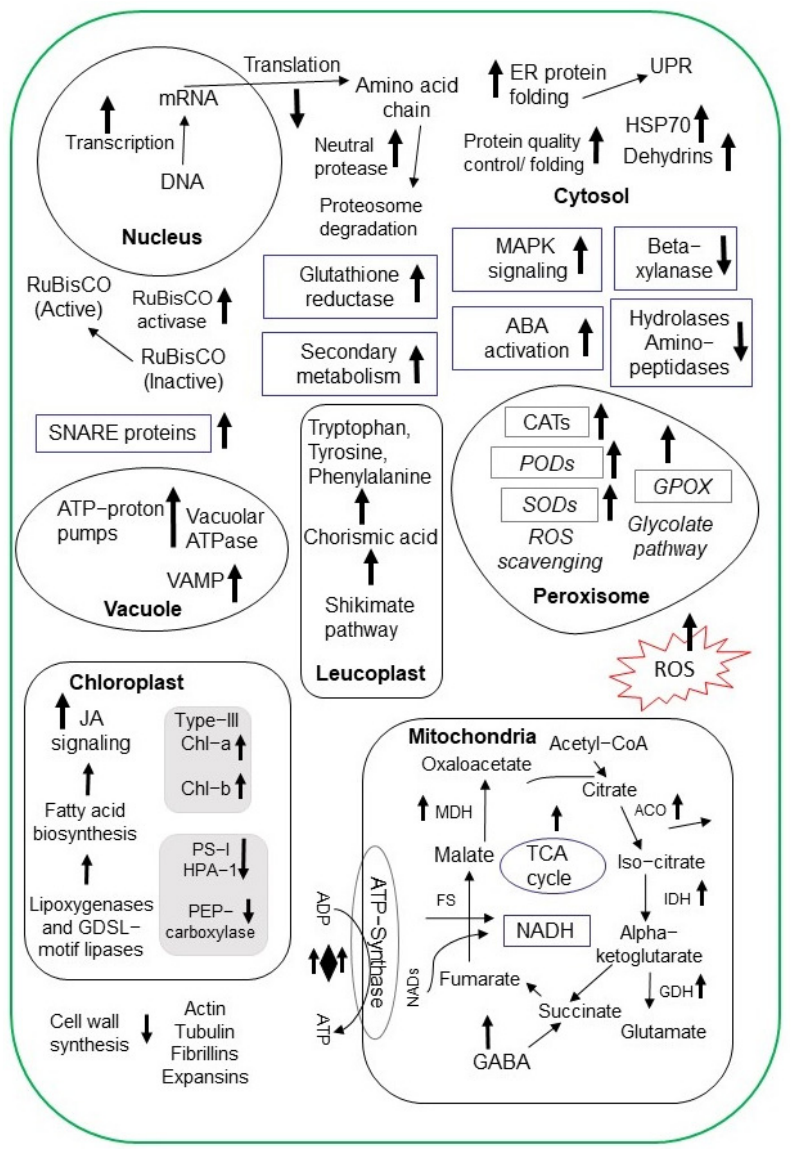
Figure 3. Proteomic alterations of salt-stress-responsive proteins in crop plants. Increased and de- creased proteins are highlighted with upward and downward black-colored arrows, respectively.